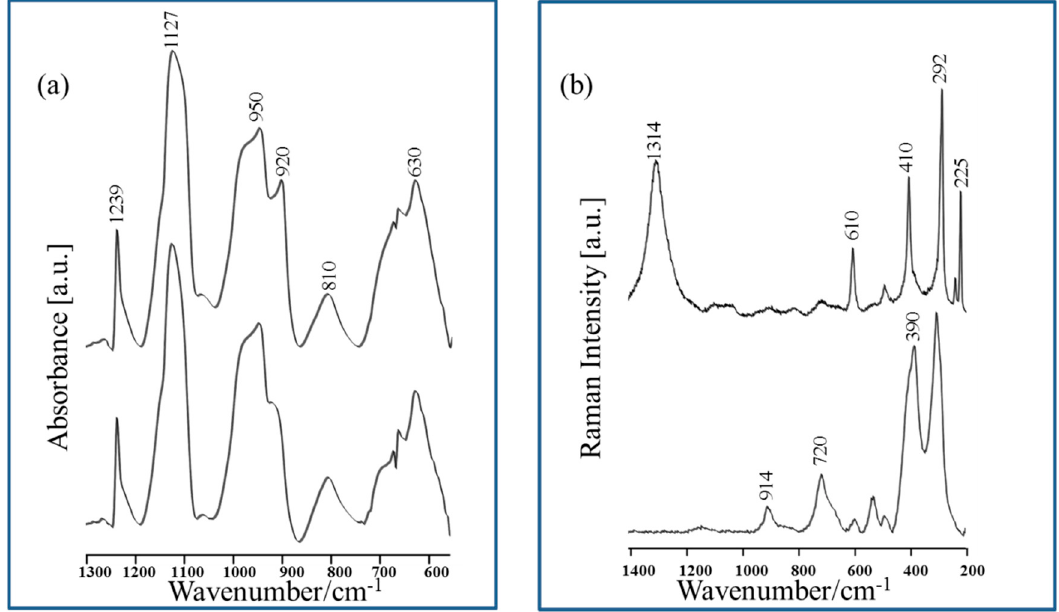
Figure 2. ( a ) The reference FT-IR spectra (top and bottom) of the corroded CuNPs-Fe sample. Measurement conditions: spectral range, 1300–550 cm − 1 ; detector MCT (Mercury–Cadmium–Telluride). ( b ) The reference Raman spectroscopy (RS) spectra (top and bottom) of the corroded CuNPs-Fe sample. Measurement conditions: spectral range, 1400–200 cm − 1 ; laser line, 632.8 nm.